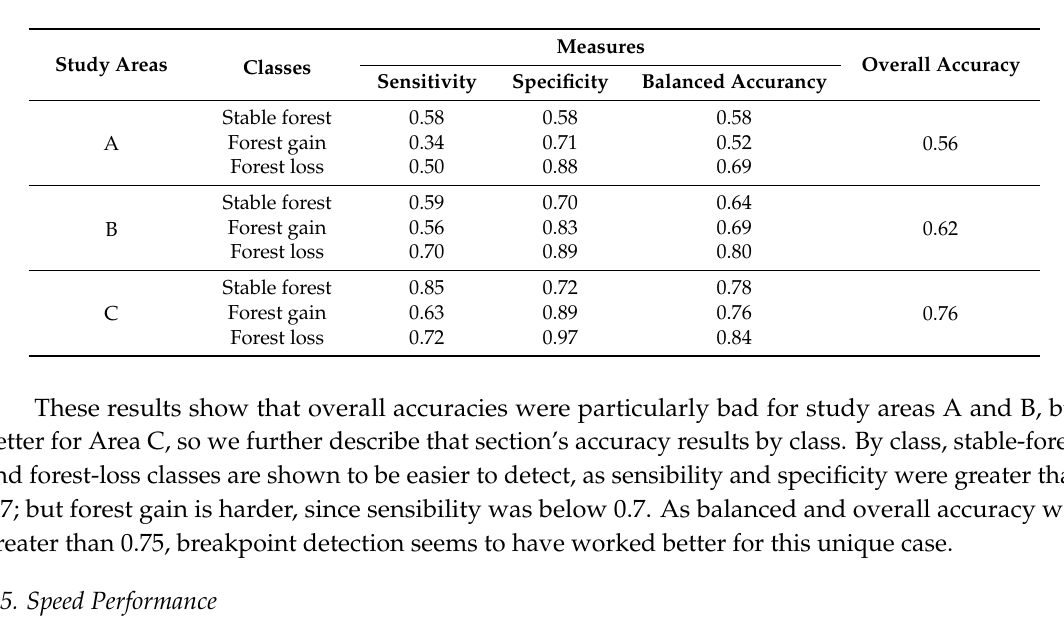
Table 6. Accuracy measures for the three study areas.